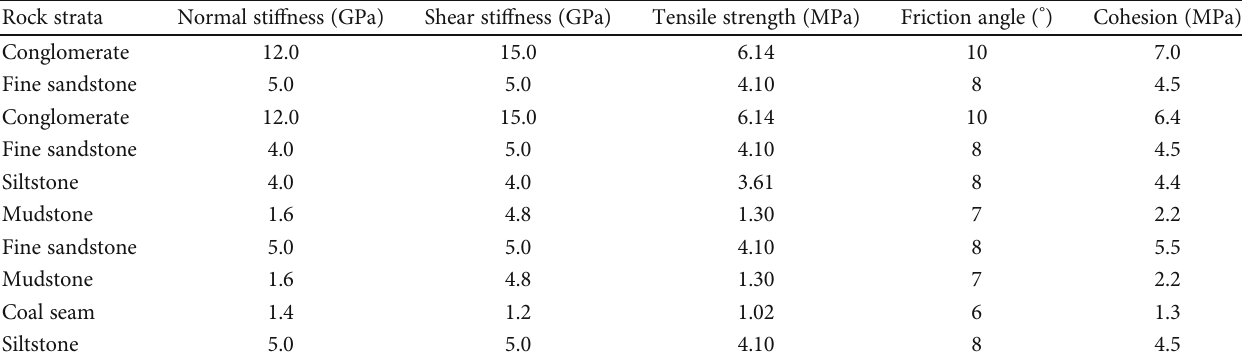
Table 4: Mechanical parameters of structure plane between